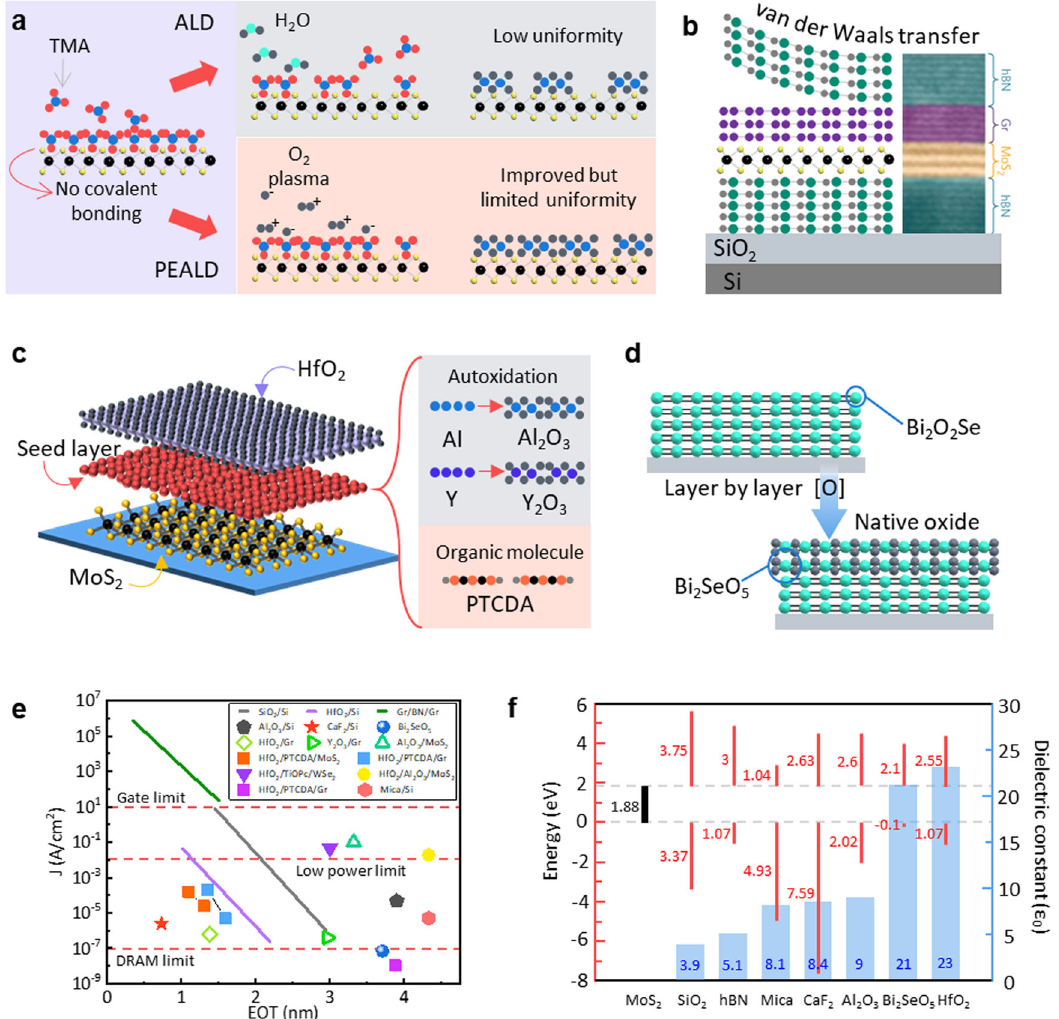
Fig. 5 Dielectric characteristics of 2D semiconductors. a Illustration of direct growth of a conventional high- κ dielectric on 2D semiconductors. The upper and lower panel show the ALD and PEALD processes respectively. b Schematic of hBN as a dielectric by vdW transfer. c Illustration of covering a seed layer to deposit high- κ dielectric. d Growth of high- κ Bi 2 SeO 5 dielectric by in situ native oxidation from Bi 2 O 2 Se. e Leakage characteristics in comparison with Si and 2D semiconductors from different dielectric technologies. e are reproduced from ref. 73 . f Comparison of band diagram and dielectric constants between MoS 2 and different